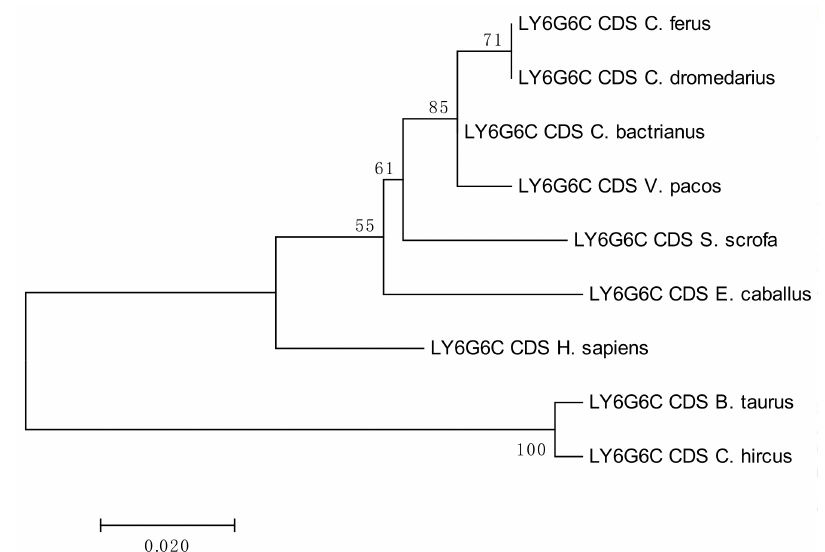
Figure 3. Phylogenetic tree of the LY6G6C CDSs from selected species. The maximum-likelihood method was used based on the Jukes-Cantor model. The number of bootstraps was 1000.